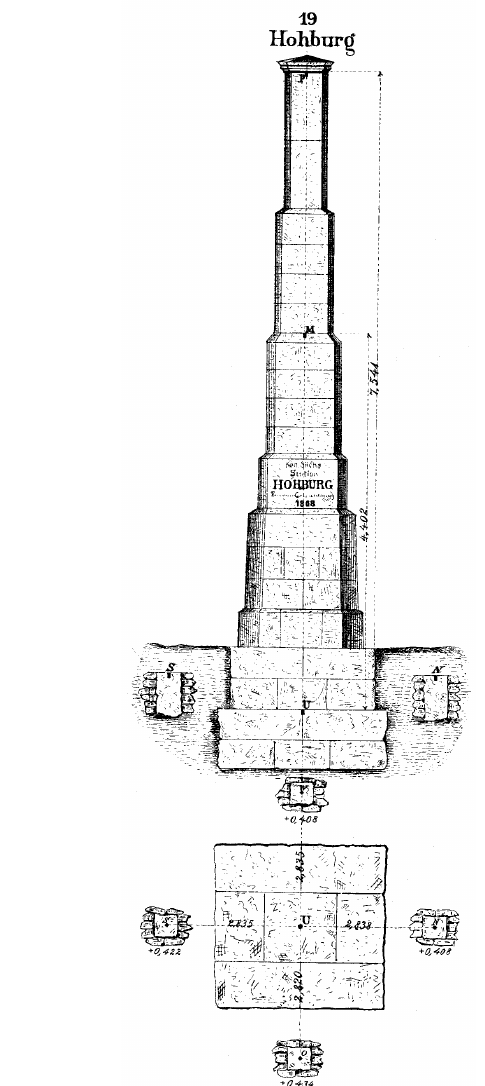
Figure 2. 7.5m high Saxon geodetic pillar in Hohburg, built in 1868 under Helmert’s supervision (Nagel,